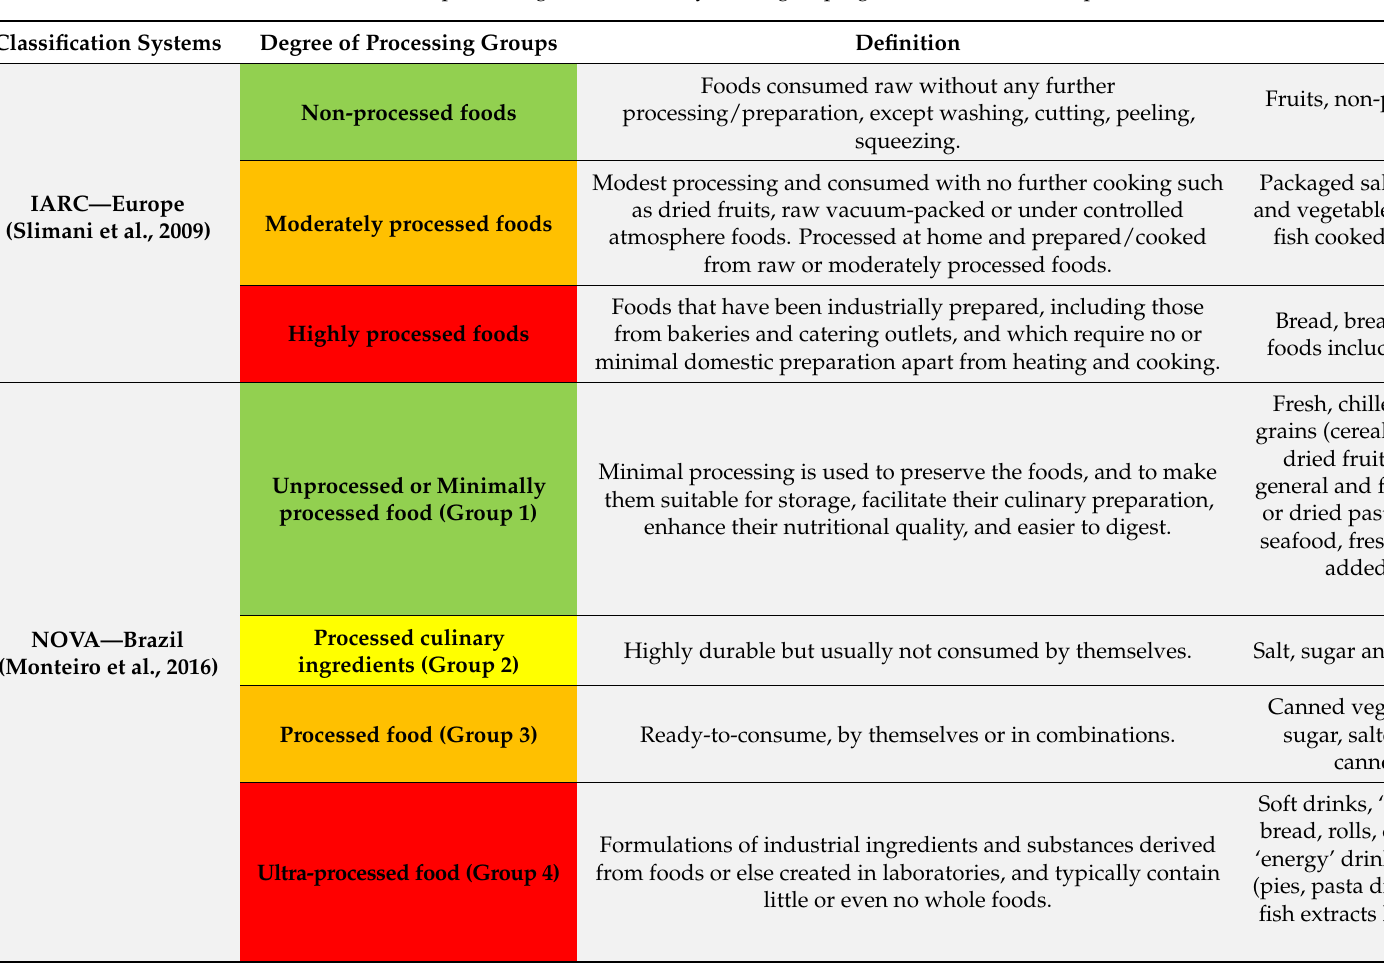
Table 1. Food processing classification systems: grouping definitions and